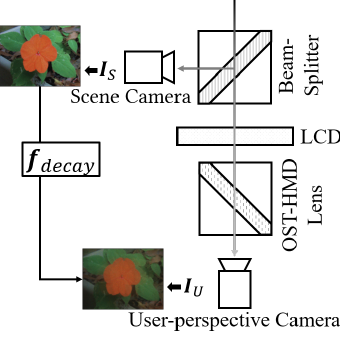
Figure 4. f decay : The relationship between I S and I U when the LCD was set to highest transmittance and the OST-HMD had no output.